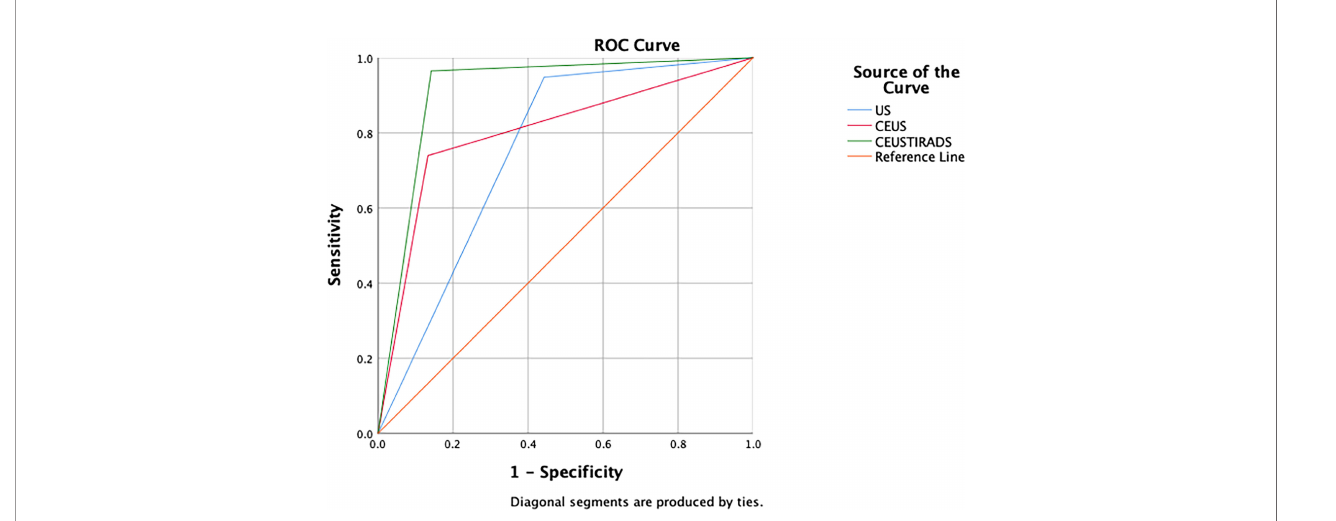
FIGURE 4 | The ROC curves of C-TIRADS, CEUS, and CEUS-TIRADS of 228 nodules in the diagnostic